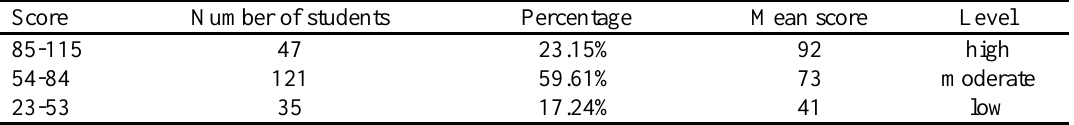
Table 5. Summary of Students’ Level of Language